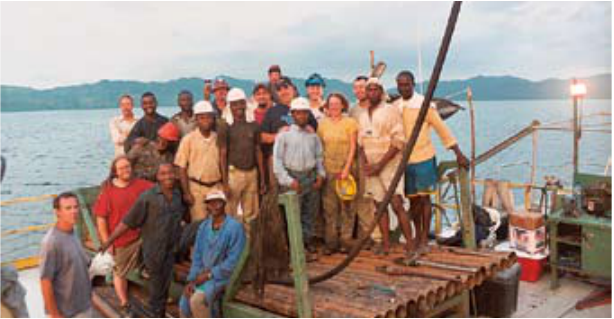
Figure 3. Group photo of sediment drilling team at Lake Bosumtwi after having completed site 4 to rock at a depth of 240 mblf. back row (l-r): Donald Bagley, James Addo, Sylvester Blay, Dave Altman, Kevin Loveland, Chris Walters (far back), Doug Schnurrenberger, Adam Carey, Tim Shanahan; middle row (l-r): Jannadi Lapukenu, Daniel Somuah, Eric Boahen, Bernard Worlanyo, Anna Henderson, Anthony, Kofi; front row (l-r): Jack Greenberg, Chip Heil, Ailwasi Opoku, Kwame Ahumah. Not shown (on shore): Phil Fox, Brad Hubney, Chris